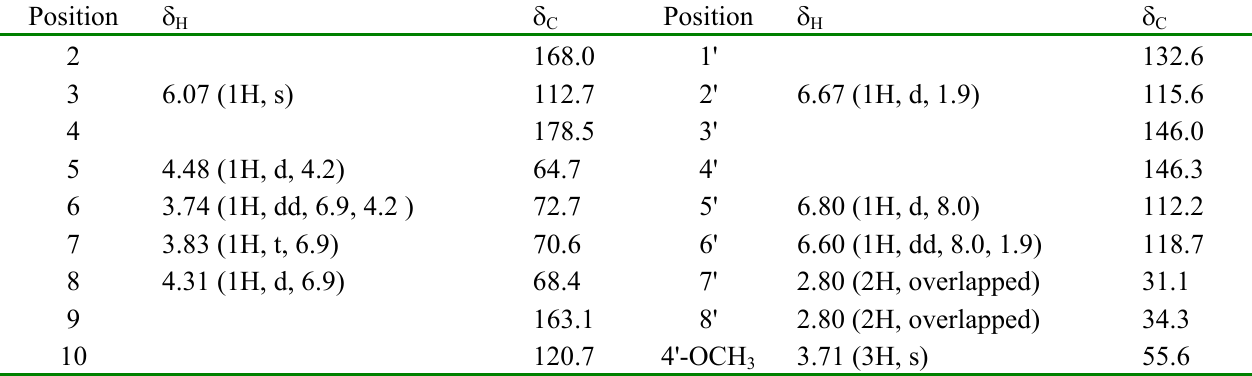
( 1 H: 400MHz; 13 C: 100 MHz; δ in ppm, J in 6